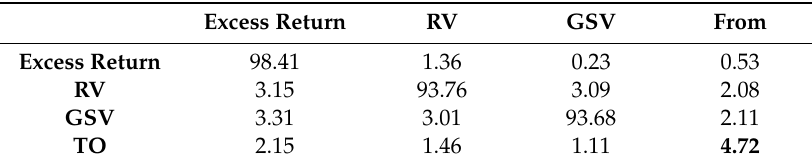
Table 8. Total spillover, Bosnia and Herzegovina.